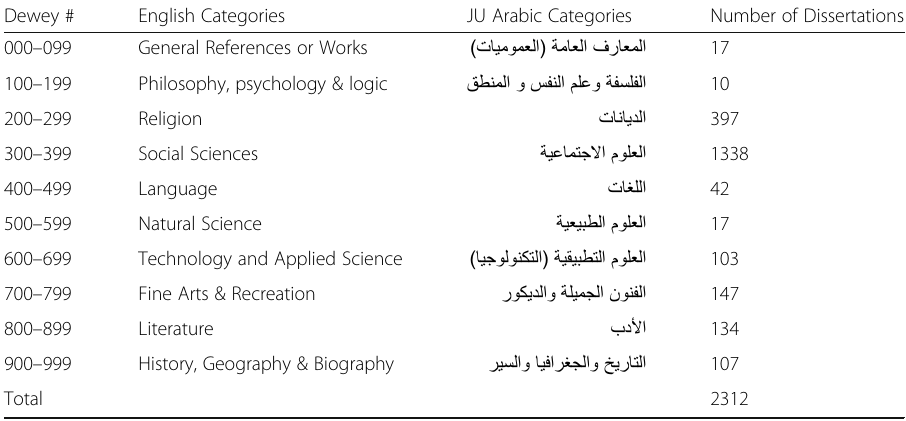
Table 3 Distribution of the corpus dissertations in accordance with Dewey ’ s categories